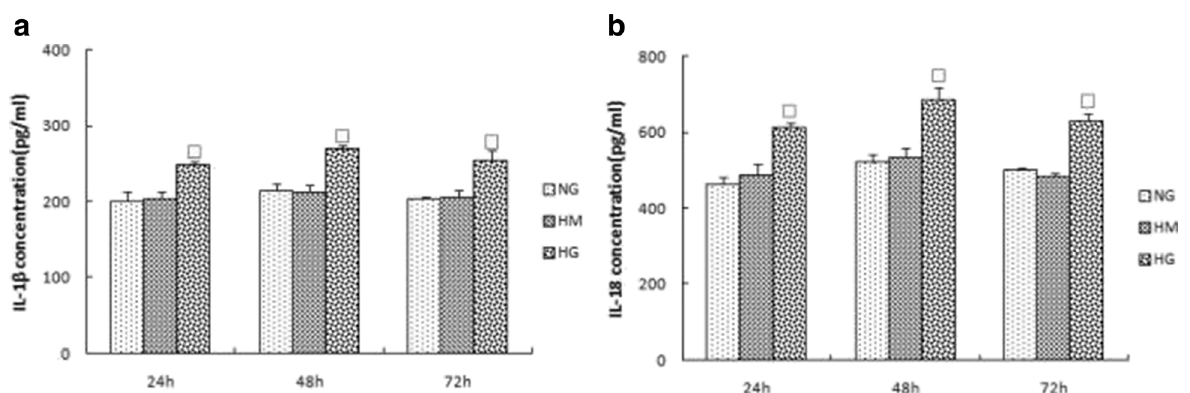
Fig. 4 a , b Expression of IL-1 β and IL-18 in NG,HM,HG group at various time points (24 h,48 h,72 h).The protein levels of IL-1 β and IL-18 in culture supernatants were determined by ELISA. NG:normal control group,HM:mannitol osmotic pressure control group,HG:high glucose group.Data are presented in mean ± SD, □ P < 0. 05 versus normal control group